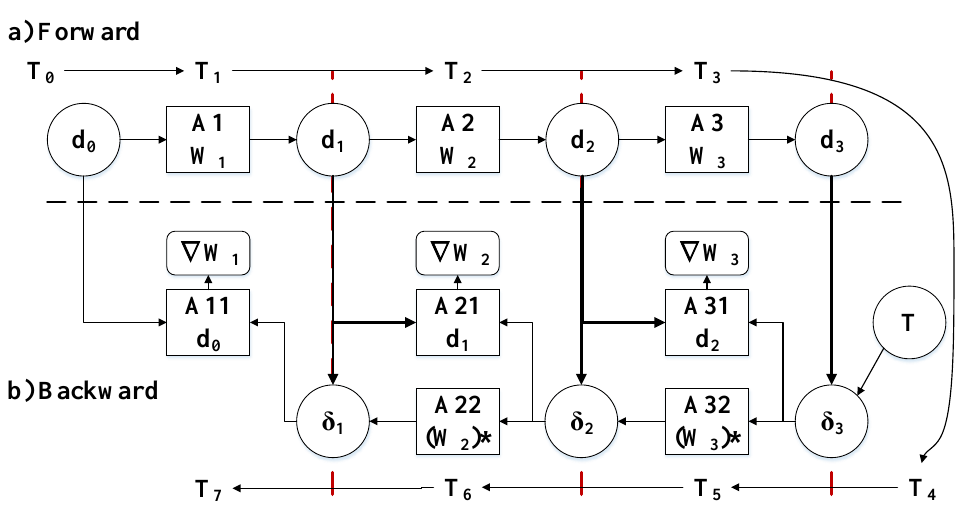
Figure 22. Example of PipeLayer configured for training (adapted from [53]). ( a ) Forward Computa- tion; ( b ) Backward